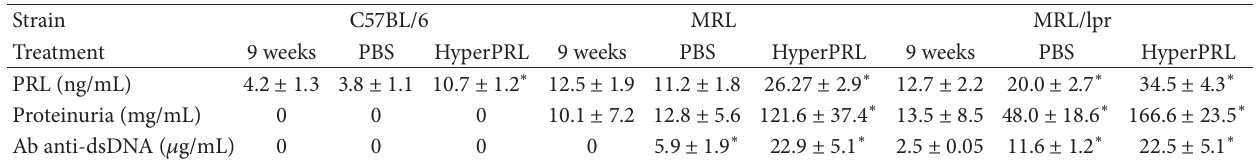
Figure 2: Expression of prolactin receptor in B cells. PRL receptor expression (MFI) was measured using flow cytometry from eight mice per strain. BM cells were labelled with anti-B220, anti-CD43, anti-CD23, anti-IgM, and goat anti-PRL receptor antibodies; the isotype control was labelled with anti-B220, anti-CD43, anti-CD23, anti-IgM, and goat unrelated antibodies. (a) Pro-B, pre-B and immature from C57BL/6 mice; (b) histograms of PRL receptor expression in B cells from BM; (c) pro-B, pre-B, and immature from MRL mice; (d) pro-B, pre-B, and immature from MRL/lpr mice. The asterisks denote statistical significance with the 𝑃 value shown. The MFI values expressed in the graphs correspond to the MFI values minus the isotype control. Table 1: SLE manifestations in mice with